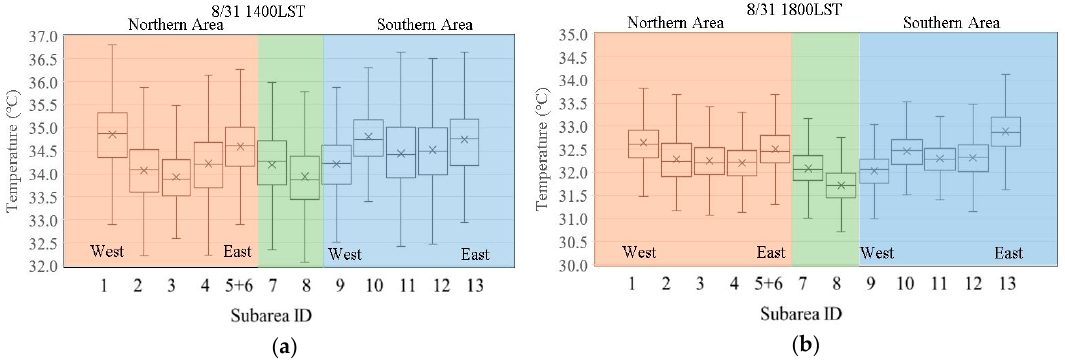
Figure 7. Box plots of the air temperatures in each subarea on 31 August 2010. ( a ) 1400 LST, ( b ) 1800 LST. Subarea IDs are shown in Figure 1c. Green background shows subareas in the Nakanoshima district. Subarea 5 and 6 were merged on this